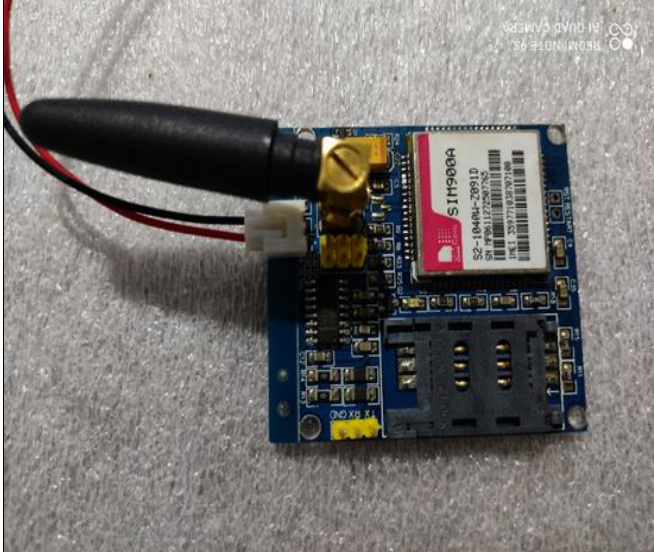
Figure 2: The GSM SIM900A module to communicate with Arduino board.